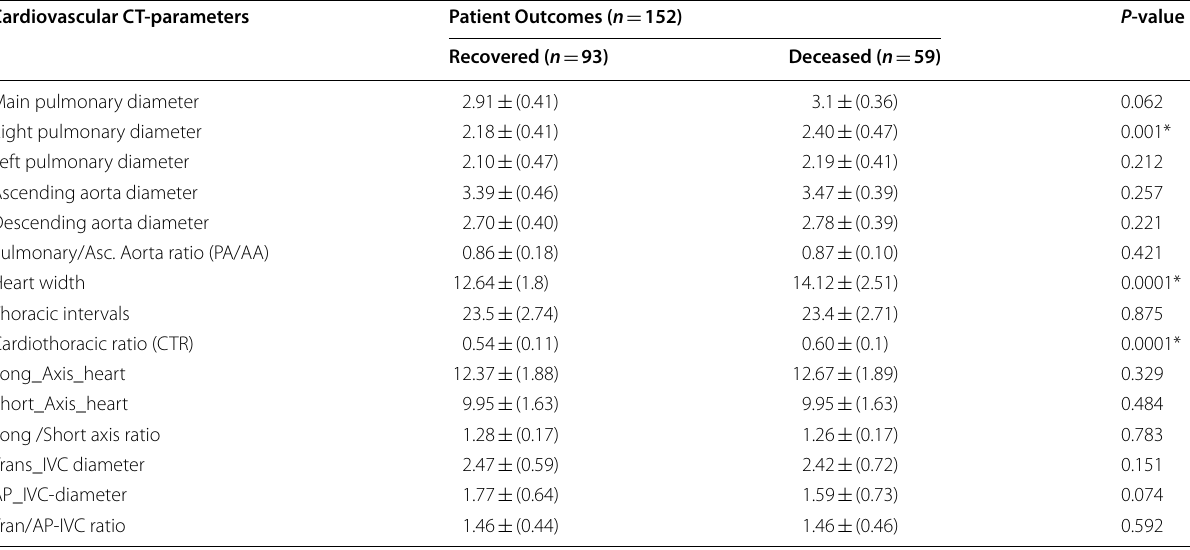
Table 3 Cardiovascular CT‑Parameters of COVID‑19 patients